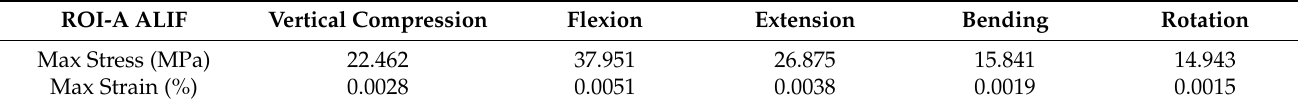
Figure 18. Stress as a function of fusion cages for five different motion modes.